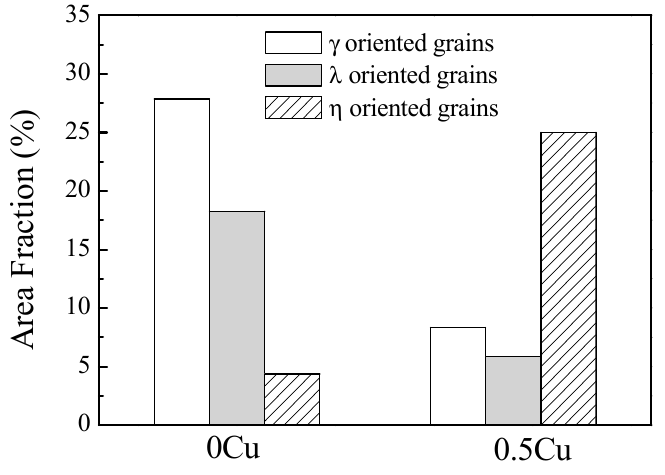
Figure 6. Proportion of γ , η and λ oriented grains in all recrystallized grains after annealing at 900 °C for 30 s (deviation angle: 15°).